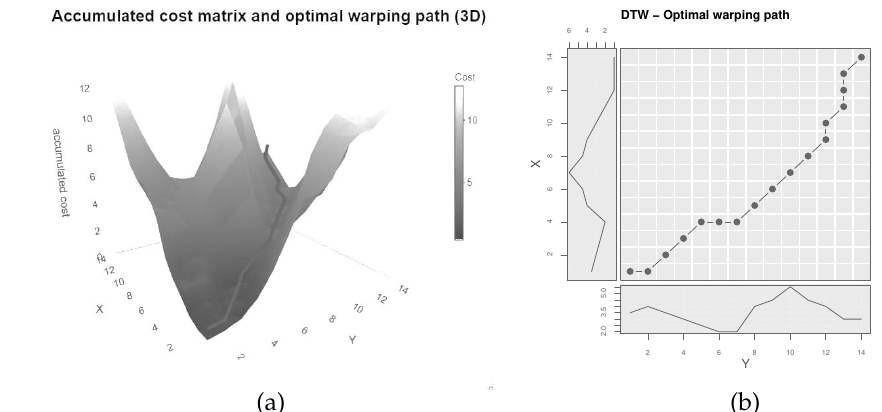
Figure 4. ( a ) accumulated cost matrix of the two time series X and Y ; ( b ) optimal warping path of the two time series X and Y